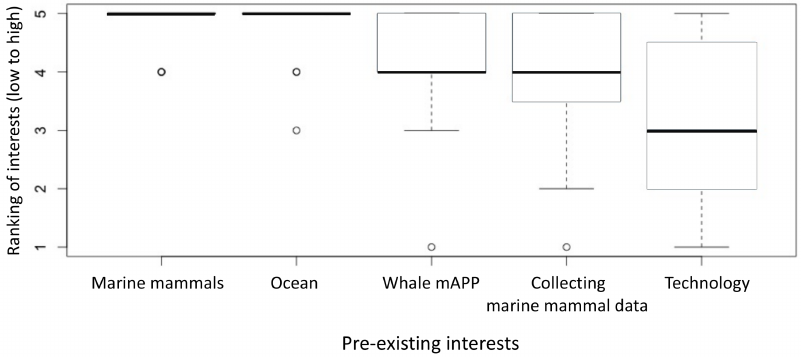
Figure 4. Boxplot of volunteer rankings of pre-existing interest on a scale of 1 (low) to 5